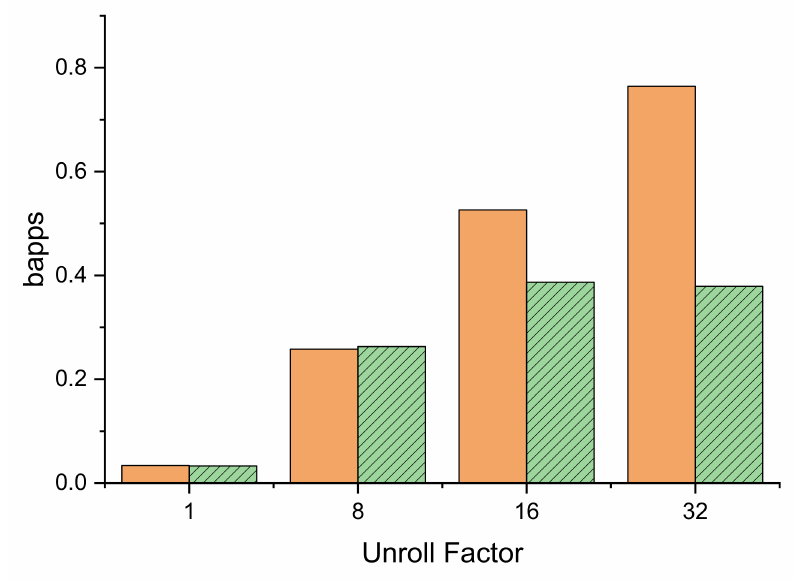
Figure 6. Processing rates per billion atom pairs for 16-bit (plain orange) and 32-bit (dashed green) transmission formats at unroll factors from 1 to